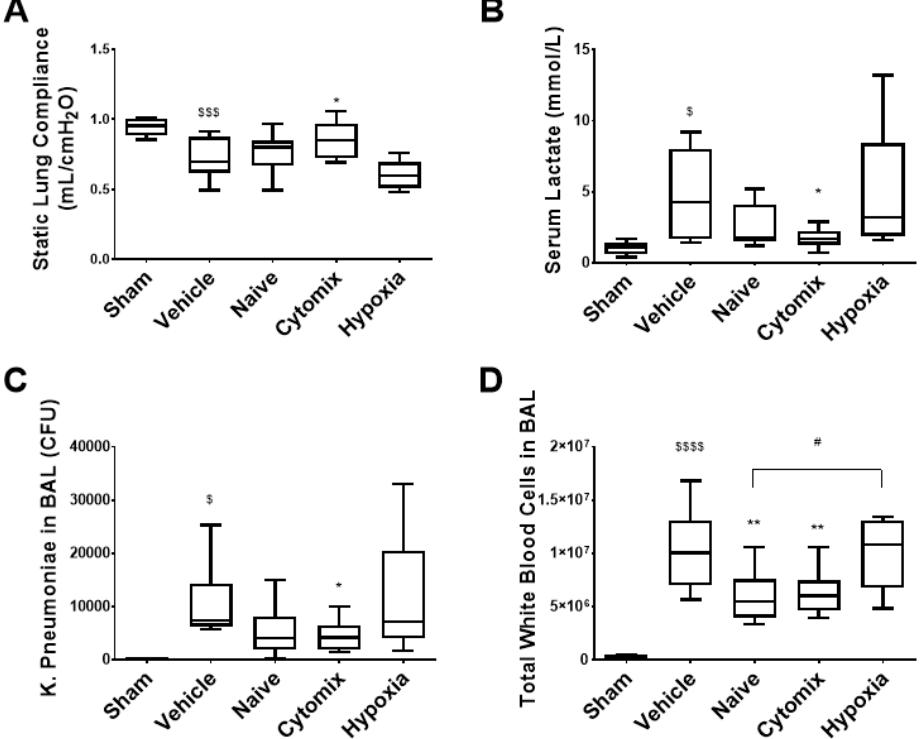
Figure 2. Respiratory static compliance was significantly improved with the application of cytomix- pre-activated MSCs and appeared to be worsened by the administration of hypoxia-exposed MSCs ( A ). The serum lactate was significantly reduced after the administration of cytomix-pre-activated MSCs compared to the vehicle control ( B ). Viable bacteria in the BAL fluid were significantly reduced in animals treated with cytomix-pre-activated MSCs ( C ). The number of pulmonary white blood cells was significantly elevated in the vehicle control group compared to the sham ( D ), whereas the naïve and cytomix-pre-activated MSC-treated groups had significantly lower white cell counts in the BAL than in the vehicle control. Hypoxia pretreatment did not improve the total white cell infiltration and was significantly worse than the naïve MSC treatment ( D ). CFU = colony forming units. Box plots and whiskers represent the minimum, first quartile, median, third quartile, and maximum. *, **, = p ≤ 0.05, 0.01 with respect to the vehicle control. $, $$$, $$$$ = p ≤ 0.05, 0.001, 0.0001 with respect to the sham group. N = 8–12. # = p ≤ 0.05 with respect to other treatment.